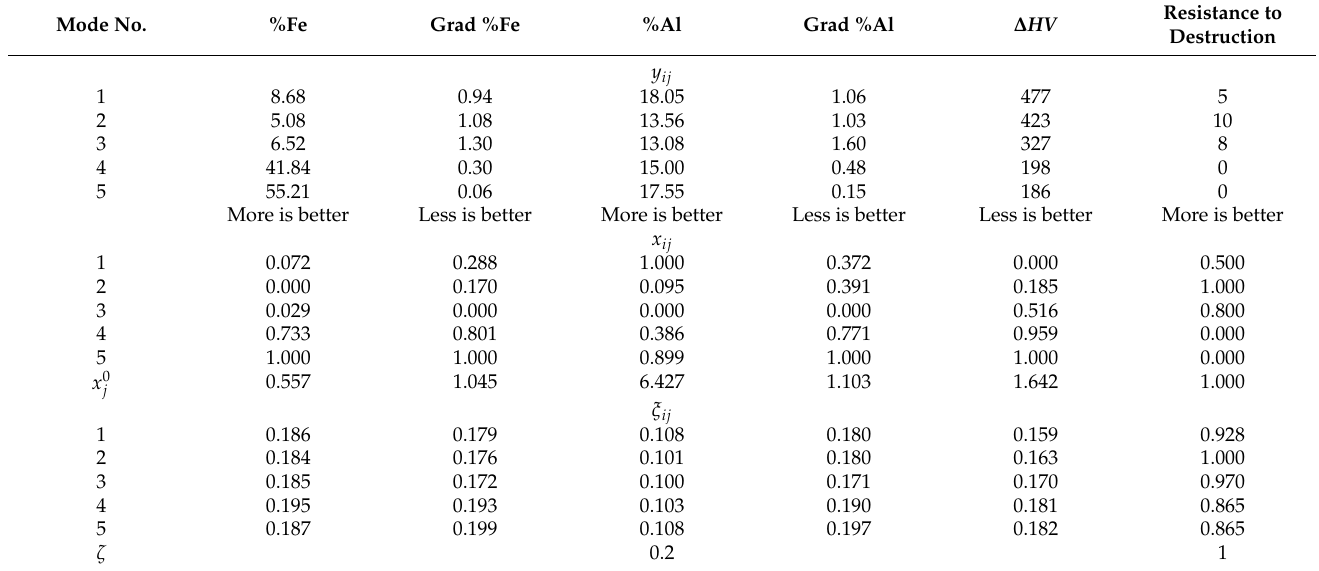
Table 7. Coefficients of gray relational analysis of quality indices for bimetal